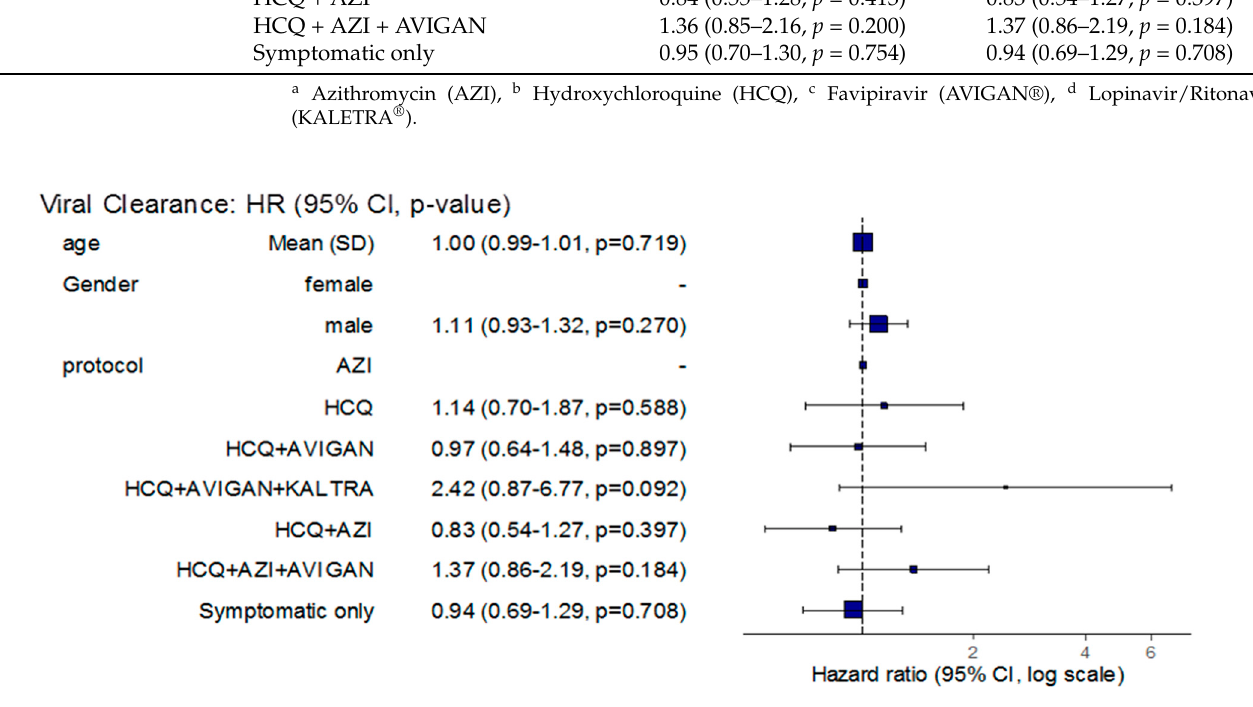
Figure 2. Cox regression model for age and gender of patients administered different antiviral protocols.